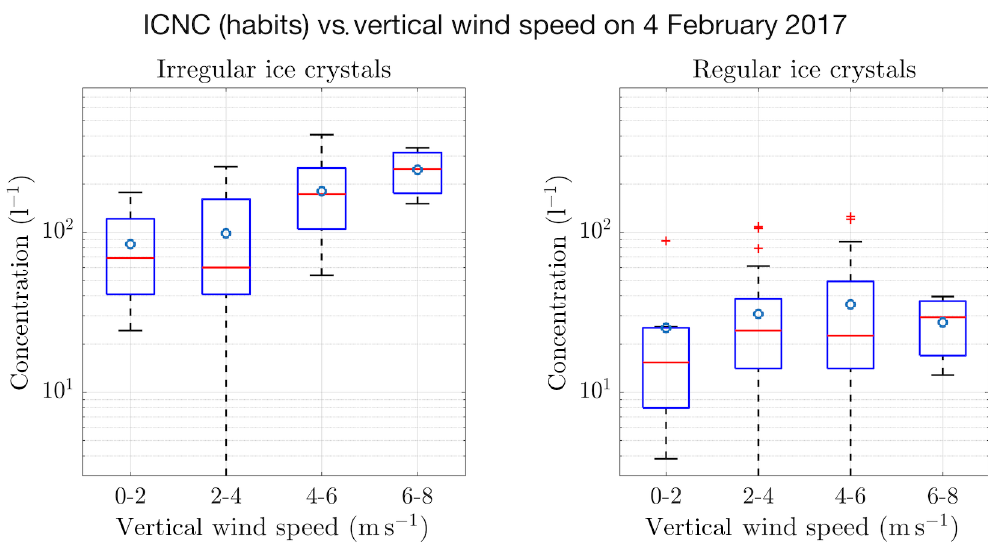
Figure 13. As Fig. 9, but only for 17 February 2017 for the ICNCs of different ice crystal habits as a function of the vertical wind speed. Aggregates are not shown because of their very low